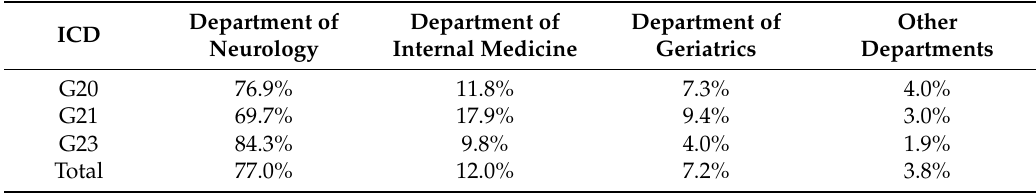
Table 6. Distribution of inpatient treatment (ICD G20–G23) among the different departments for the year 2016.